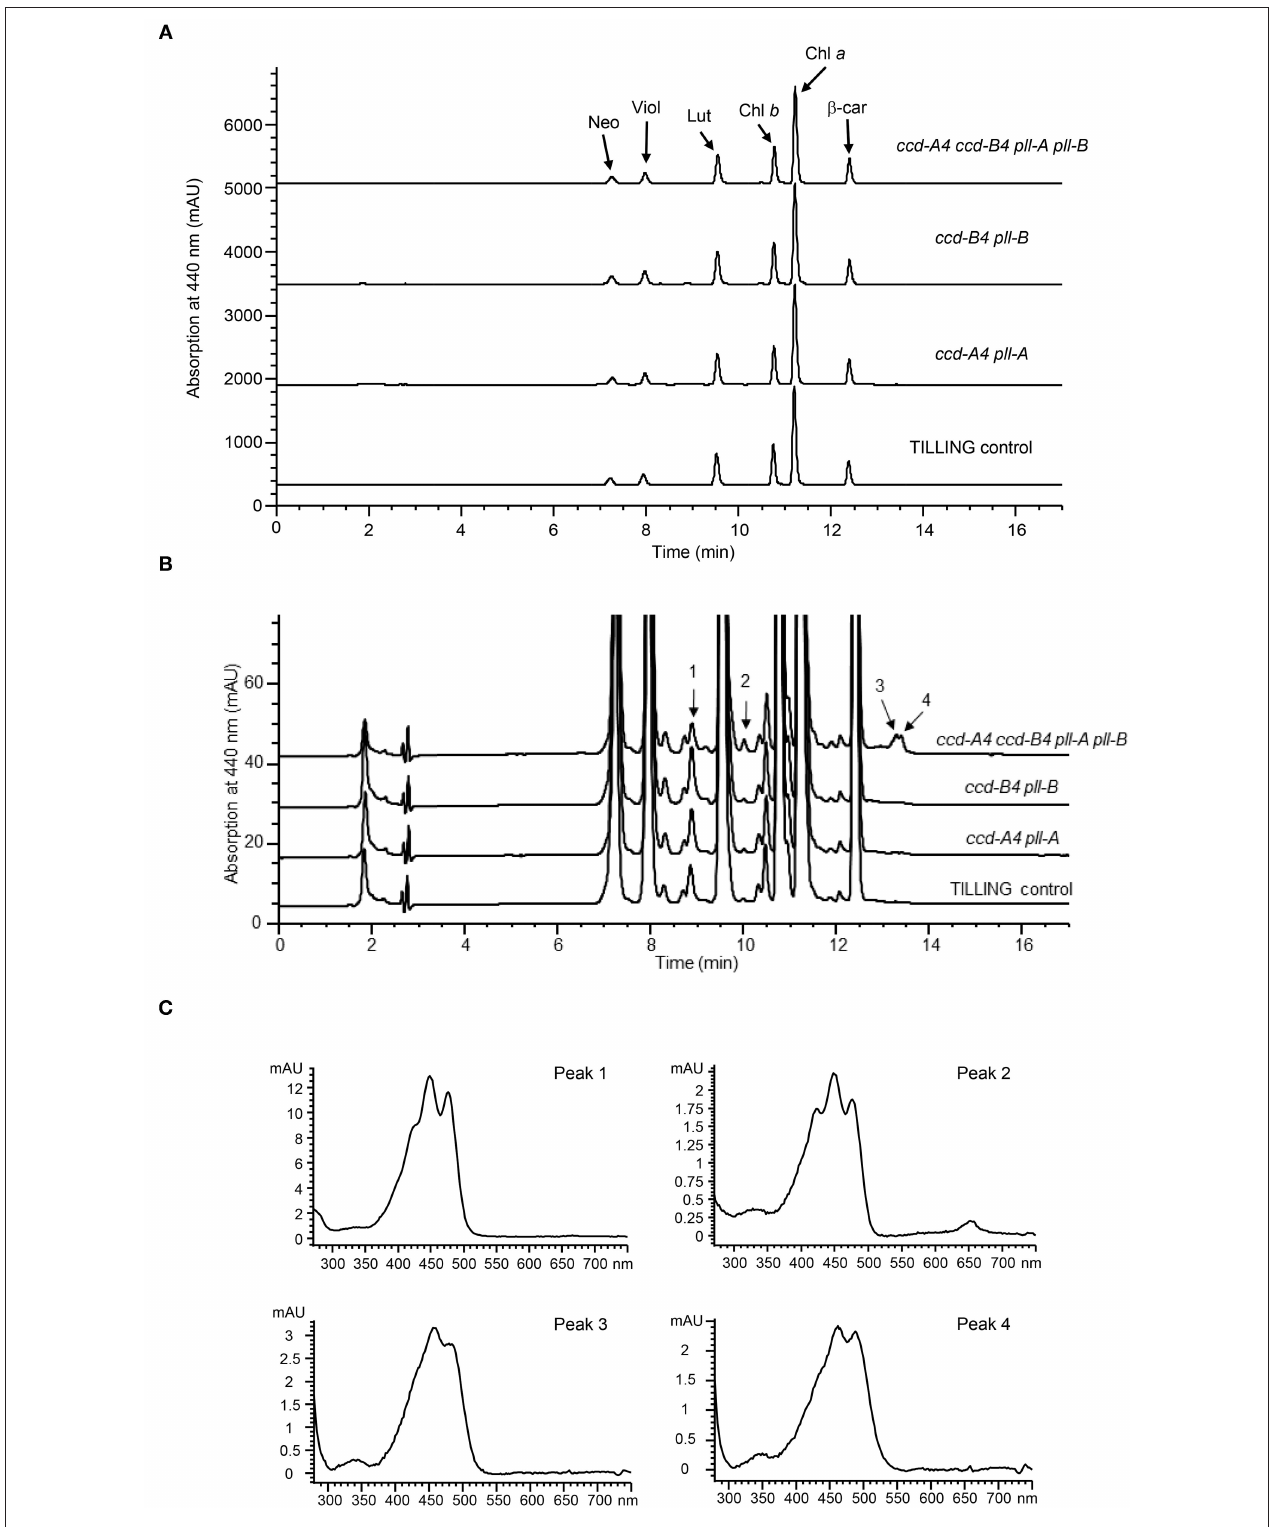
FIGURE 2 | HPLC analysis of carotenoid profiles in leaves of TILLING control and mutant plants. (A) HPLC chromatograms of TILLING control, ccd-A4 pll-A , ccd-B4 pll-B , and ccd-A4 ccd-B4 pll-A pll-B . Neo, neoxanthin; Viol, violaxanthin; Lut, lutein; Chl b , chlorophyll b ; Chl a , chlorophyll a ; β -car, β -carotene. (B) A zoomed view of HPLC chromatograms showing peaks that are differentially accumulated in ccd-A4 ccd-B4 pll-A pll-B and TILLING control. (C) Absorption spectra of peaks 1–4.